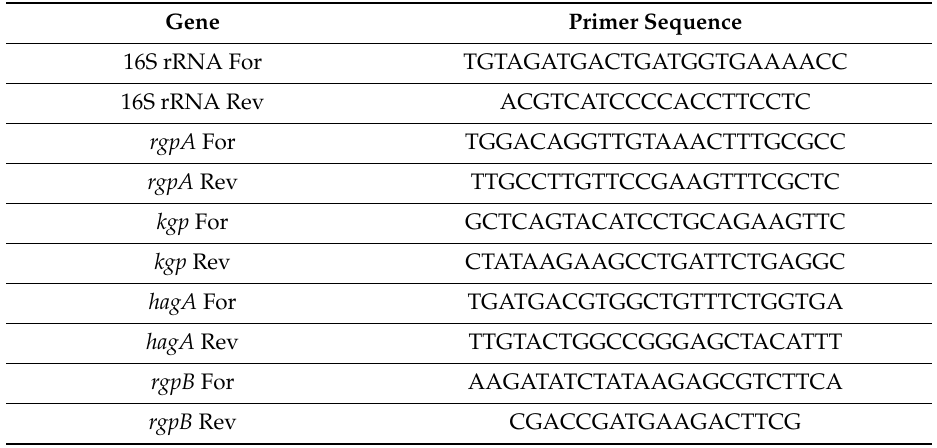
Table 1. qRT-PCR primers used in this study for the identification of gingipain gene expression. Gene Primer Sequence 16S rRNA For TGTAGATGACTGATGGTGAAAACC 16S rRNA Rev ACGTCATCCCCACCTTCCTC rgpA For rgpA Rev kgp For kgp Rev hagA For hagA